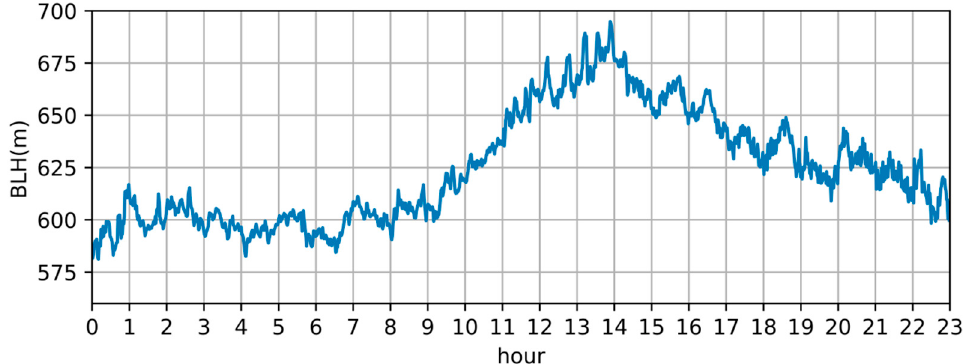
Figure 2. Daily average of boundary layer height in Sansha.